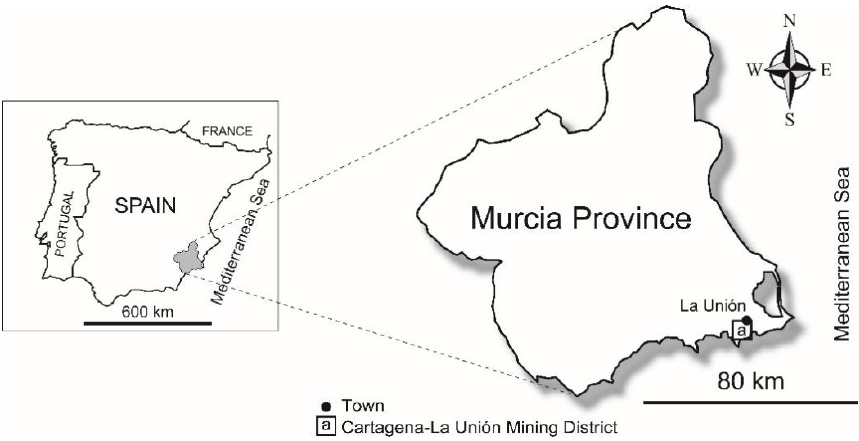
Figure 1. Location of the study area.